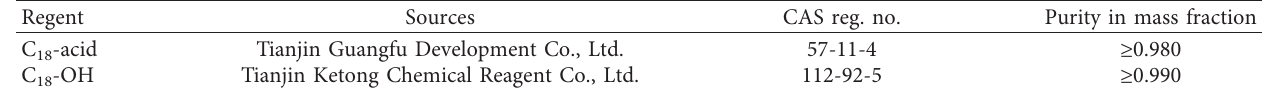
Table 1: Chemicals used in this work.